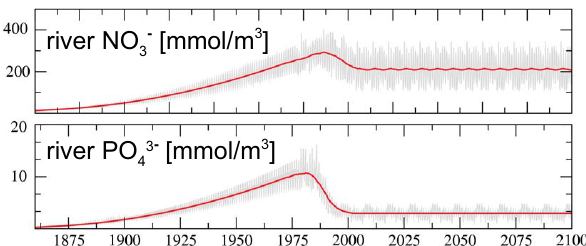
Fig. 2. Prescribed average concentration of riverine nutrient supply to the North Sea. Grey lines indicate monthly mean values. Red line indicates yearly mean